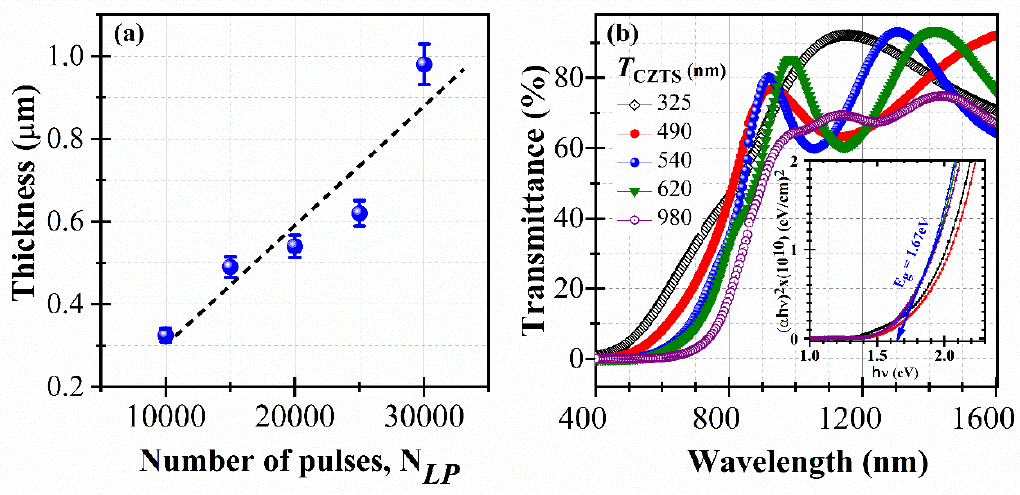
Figure 4. ( a ) Variation of thickness of the PLD-CZTS films as a function of the used N LP ; ( b ) Optical transmittance spectra of the PLD-CZTS films with their associated Tauc plots (inset) for the various film thicknesses ranging from 325 to 980 nm.